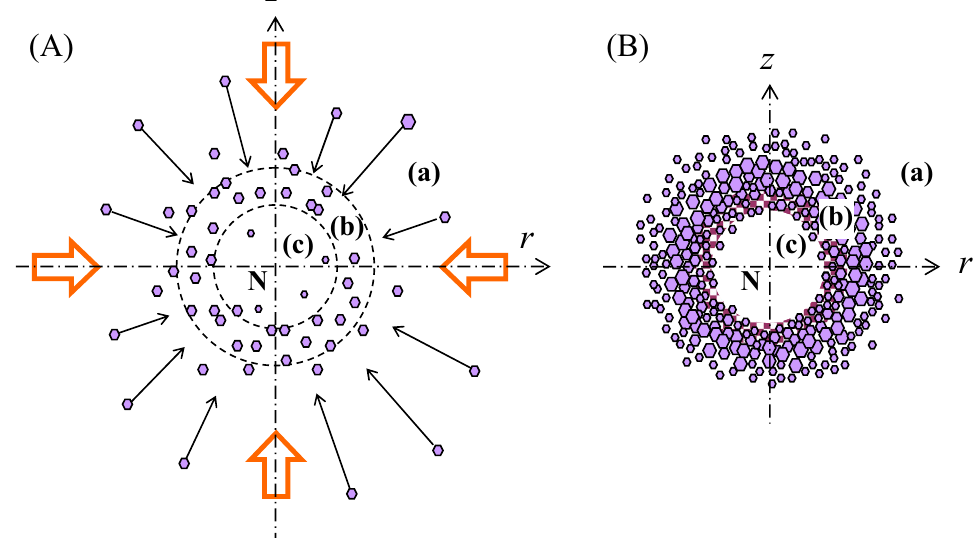
Figure 6. Schematic illustration of the spherical shell-shaped crystals. Point N is the center of the crystal. ( A ) Is the initial aggregation and ( B ) shows the well-grown state. When the nuclei generate in region (a), far away from N, they are strongly attracted, as shown by orange arrows. As the crystals get close to N, the external forces on the crystals become small, and finally the crystals are forced to stay near N. In the succession of other crystals’ concentrating, some crystals come into contact with the periphery crystals and grow large together. As a result, a spherical shell structure is shaped. Since the periphery part is constantly supplied with high-concentration protein molecules, the shell structure grows thick, as schematically shown in region (b). In contrast, mass transfer effect is suppressed in the hollow part of region (c). As a consequence, the crystals build a two-layer structure, i.e., a spherical shell outside and a hollow